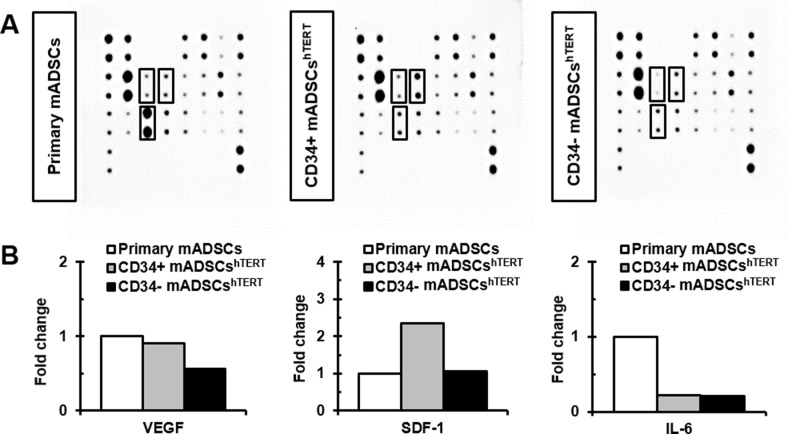
Determination of paracrine factors secreted from primary mADSCs and CD34+ and CD34- mADSCshTERT.(A) CM secreted from primary mADSCs, CD34+, and CD34- mADSCshTERT was subjected to a mouse cytokine antibody array detecting 21 cytokines in duplicate. Solid lined boxes indicate differentially secreted paracrine factors among primary mADSCs, CD34+, and CD34- mADSCshTERT. (B) Differentially expressed paracrine factors among primary mADSCs, CD34+, and CD34- mADSCshTERT were subjected to densitometry and are presented as fold changes for individual cytokines, taking primary mADSCs as a one-fold value.